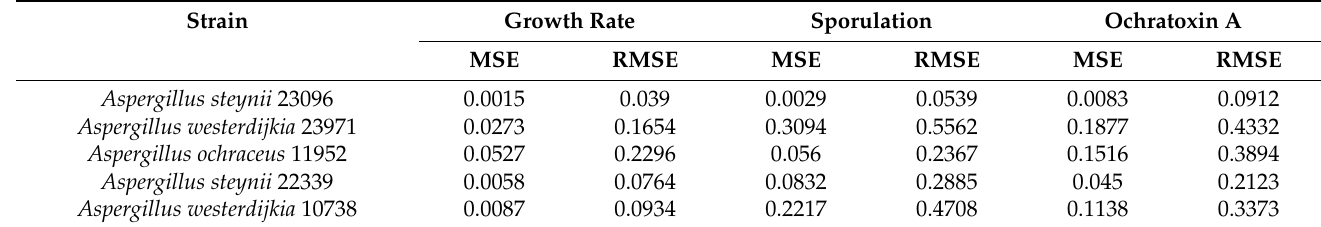
Table 3. Model validation of Aspergillus ochraceus